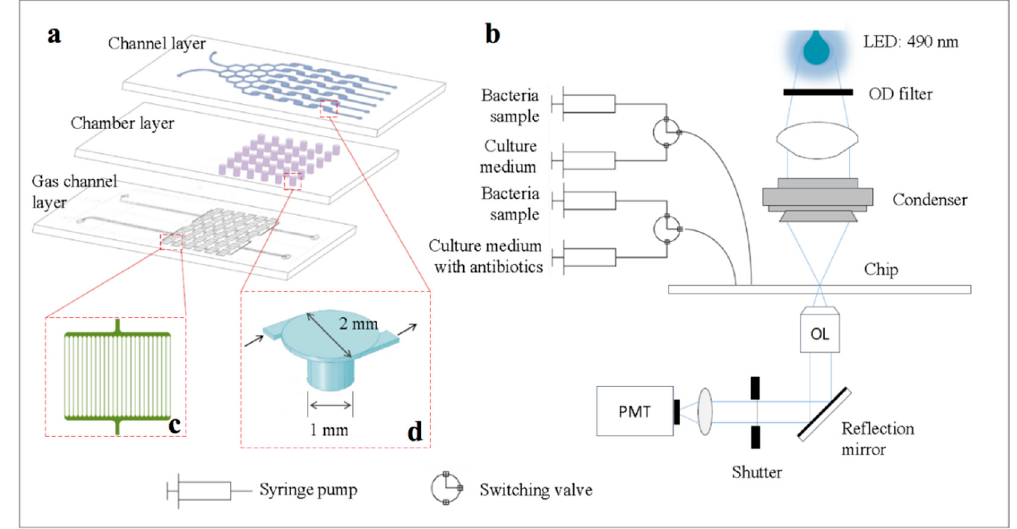
Figure 1. Schematic illustrations of chip structures and microfluidic system. ( a ) Illustration for three layers of chip: channel layer is used to generate concentration gradient of culture medium and antibiotics; chamber layer is used to culture bacteria; gas channel layer is used to remove gas in the chambers during the injection of the bacteria solution. The chip is 75 mm × 25 mm in size. ( b ) Schematic platform of culture and detection process: it consists of an inverted microscope, a data acquisition module, two three-way valves and a light-emitting diode (LED) lamp. ( c ) One gas channel array consisting of 25 microchannels with 15 µ m in width and 5 µ m in depth. ( d ) The flanged chamber for bacterial culture.